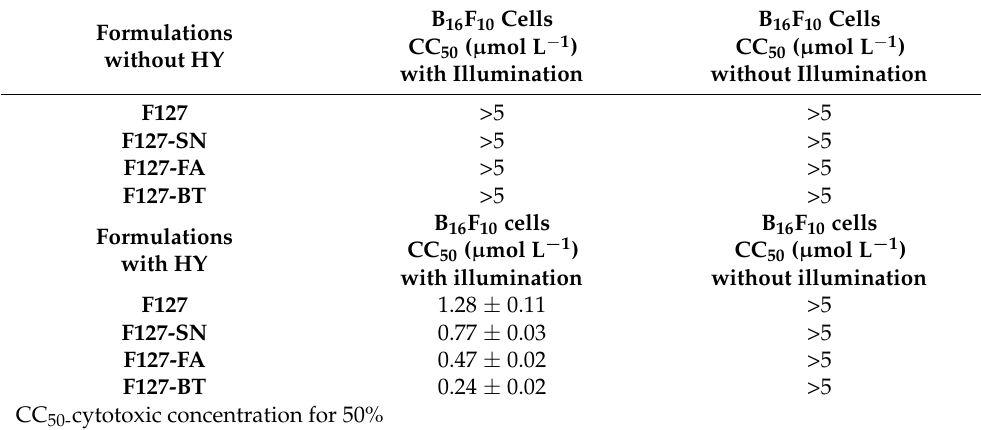
Table 2. Results obtained after photodynamic treatment for formulations with and without HY. The for- mulations without HY were also used as a control and showed no cytotoxic effect (CC 50 > 5 µ mol L − 1 ), even in